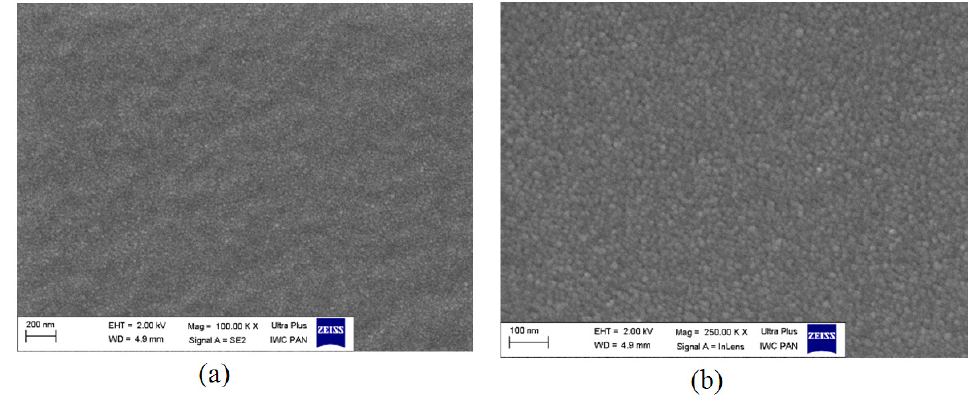
Figure 7. Scanning electron microscope (SEM) image for composite G.G.75 at ×100,000 ( a ) and ×250,000 ( b )